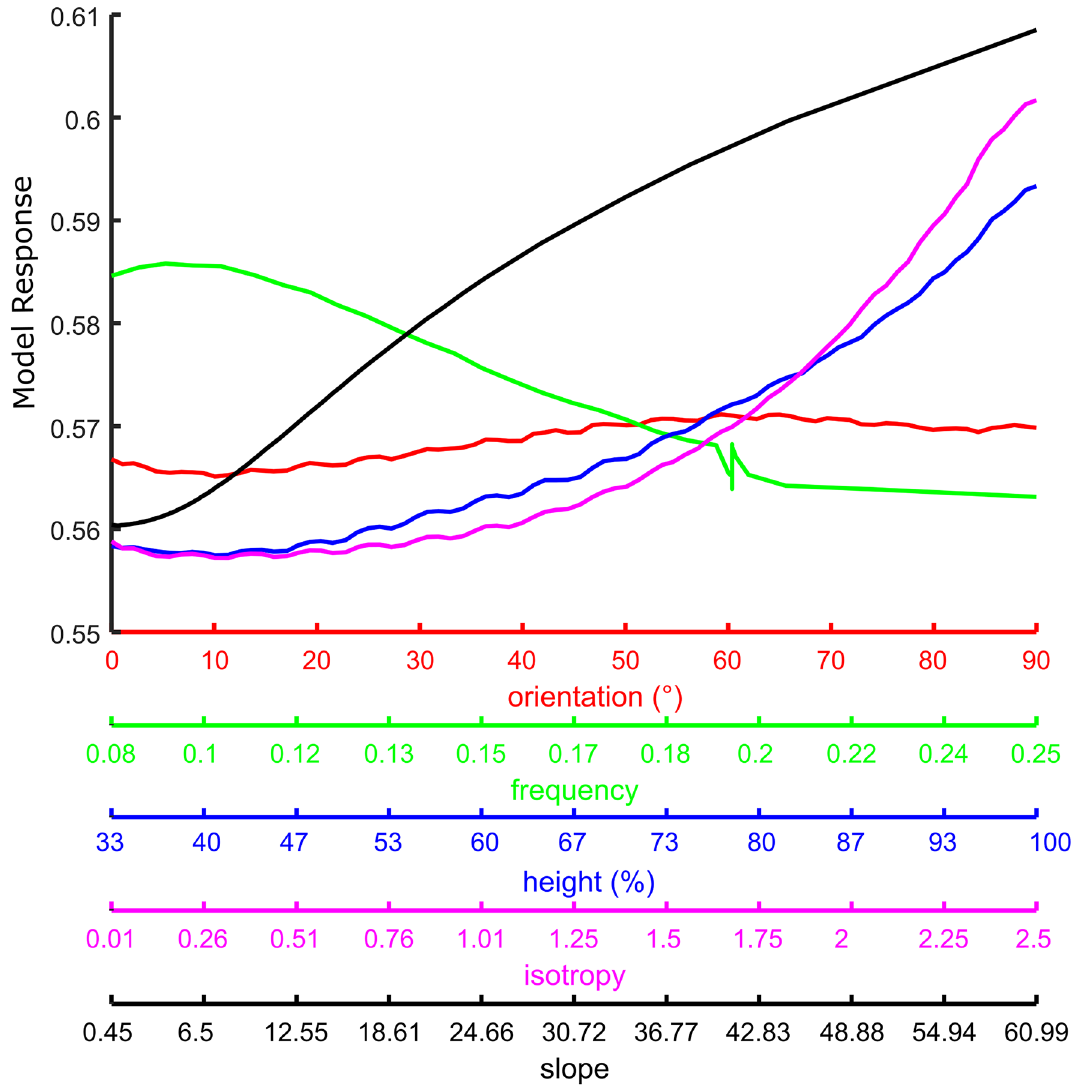
Figure 8. Reverse correlation. Model response on the y -axis, features on the x -axes: Height in blue, Orientation in red, Frequency in green and Anisotropy in magenta, slope in